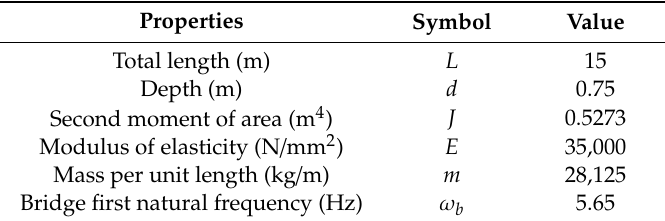
Table 2. Properties of the bridge. Reproduced from OBrien et al. Application of empirical mode decomposition to drive-by bridge damage detection. Eur. J. Mech. A Solid 2017; 61, 151–163 . Copyright © 2017 Elsevier Masson SAS. All rights reserved.